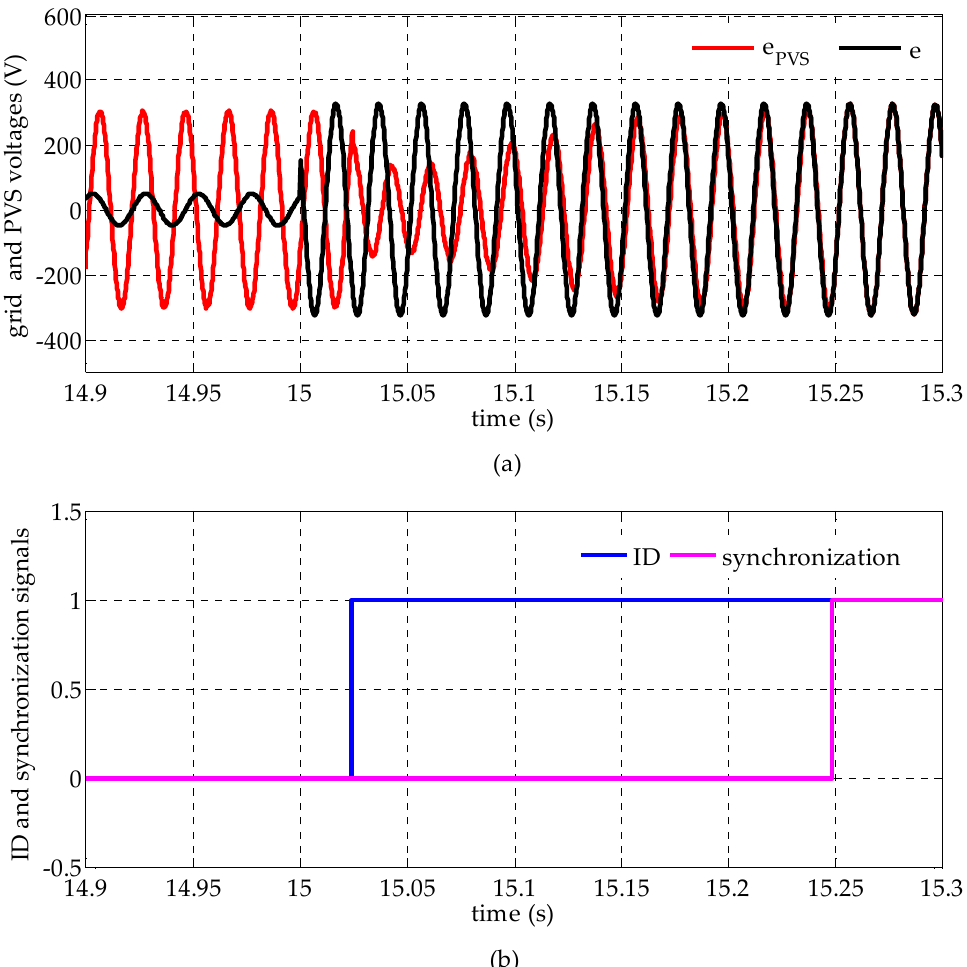
Figure 13. Grid and PVS voltages during resynchronization process. ( a ) e and e PVS waveforms; ( b ) ID and synchronization control signals.